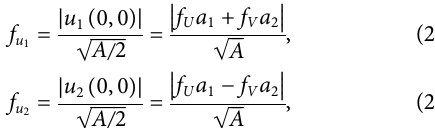
[ Figure 1F ] times as high as the average height of the periodic backgrounds, respectively. These enhancement values are all below 3 and do not seem to be different from what we observed in Manakov systems [43, 44].